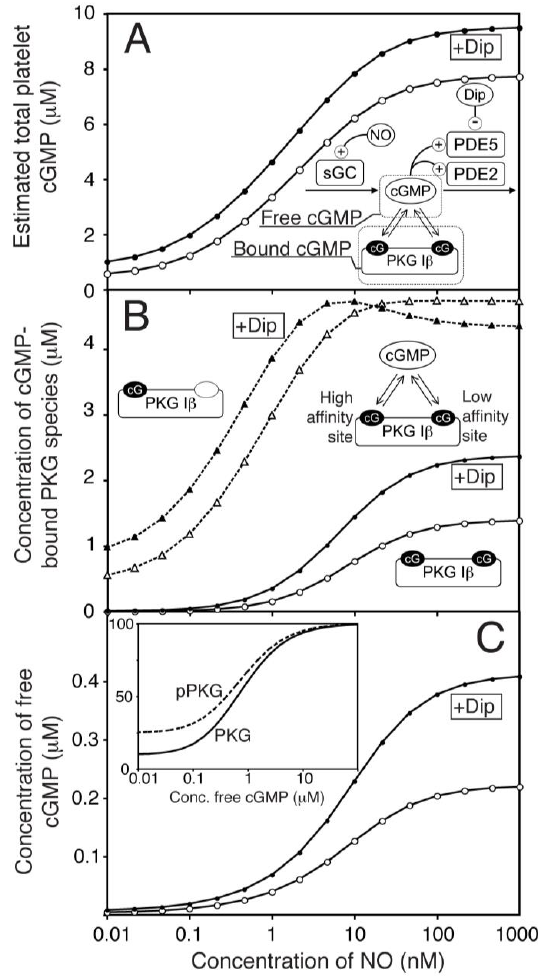
Figure 2. One-compartment model of platelet NO/cGMP signalling. (A) The total concentrations of cGMP in platelets (bound & free) were estimated by mechanistic modelling in response to different NO concentrations, in the absence ( ) or presence of dipyridamole ( , 1.0 µM). The key molecules that determine free and bound cGMP-levels are illustrated in the reaction network. ( B ) shows the computed levels of cGMP- bound PKG Iβ at different NO concentrations in the absence (open symbols) and presence (closed symbols) of dipyridamole. Binding of cGMP to the high-affinity site ( , , dotted line) and both sites ( , , solid lines) are shown. ( C ) shows the predicted concentration of free cGMP at different NO concentrations in the absence ( ) or presence of dipyridamole ( ). The inset shows predicted PKG activity at different cGMP concentrations for non-phosphorylated (solid line) and completely autophosphorylated PKG (pPKG, dotted line).